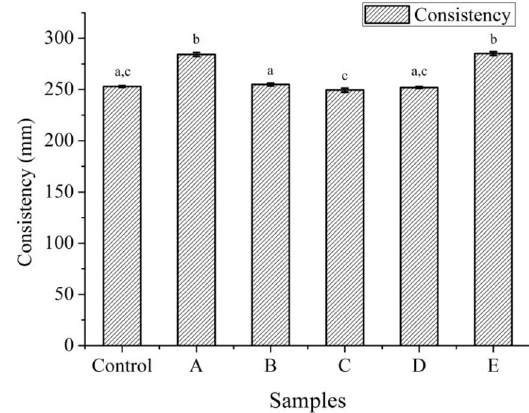
Figure 4. Thermogram of crusher residue and Differential TGA thermogram for crusher residue.